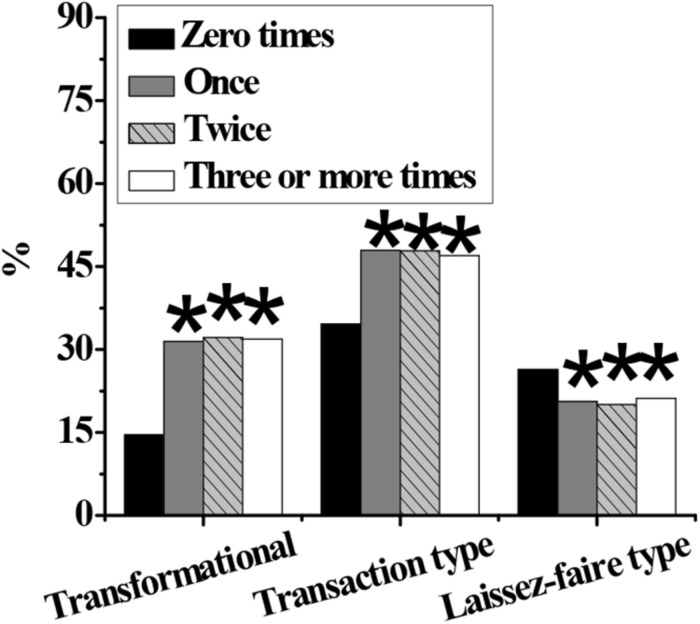
Difference in entrepreneurial times of different entrepreneurial psychological leadership styles. Note: An asterisk (*) indicates that there is a statistically significant difference compared with zero start-up (p < 0.05).